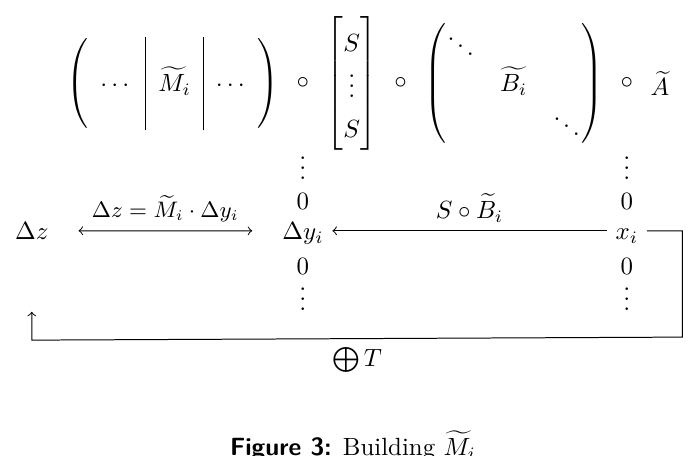
Figure 3: Building f M